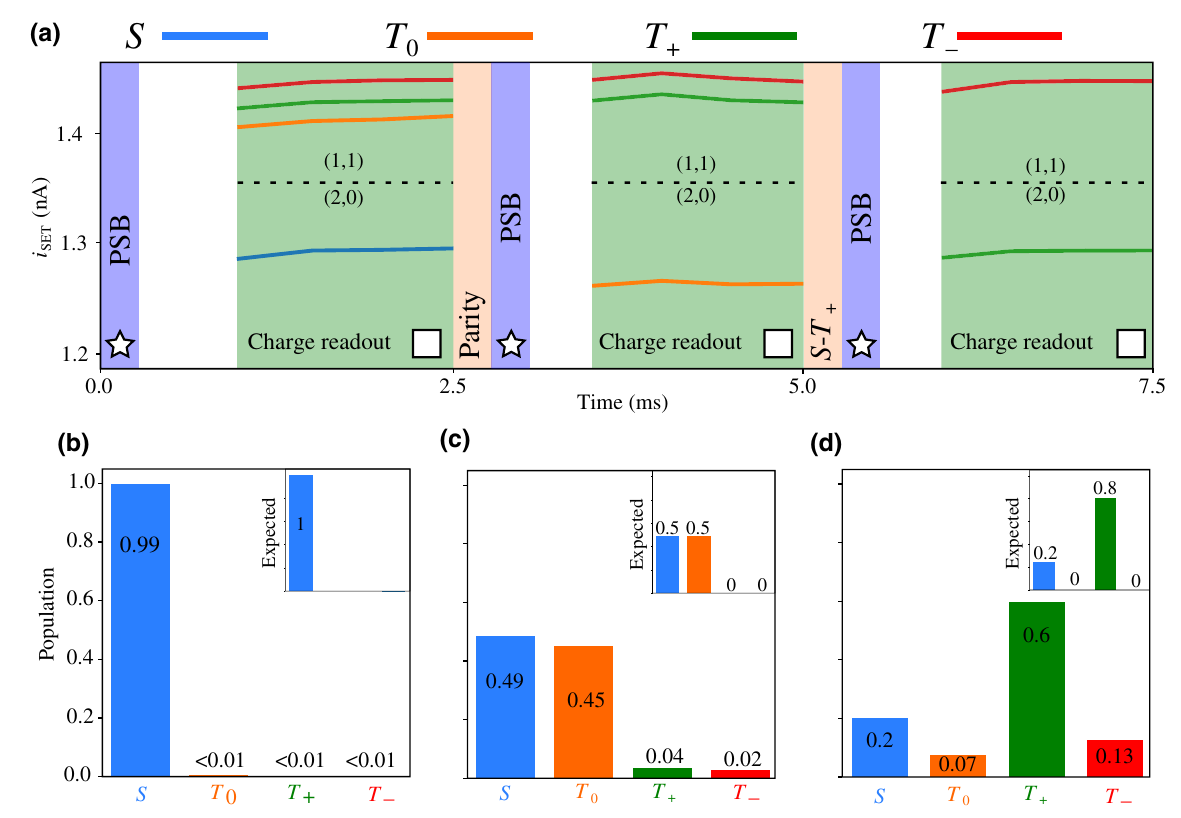
FIG. 3. Complete readout procedure and description of the three-step measurement. (a) Typical measured current across the SET during the three different steps of the readout for the four possible spin states. Blue shaded areas correspond to a pulse to the PSB position, the green shaded one is when the system is at charge-readout position. The PSB, parity and S - T + shaded area are artificially extended in the chronogram and the SET traces are slightly offset for clarity. The white area corresponds to the time needed for the system to stabilize for readout after a manipulation. (b)–(d) Output of the complete readout procedure for singlet state, S - T 0 mixed state, and T + initialization. The inset corresponds to the expected result for an errorless complete readout procedure.